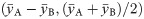
rCART association graphs for effect size.A,B: ‘Hospitalizations’ response versus ‘Emergency visits’ partition variables, with correlation r(rpbd, ρpb) = 0.93. C,D: ‘Emergency visits’ response versus ‘Hospitalizations’ partition variables, with correlation r(rpbd, ρpb) = 0.49. Bar plot histograms are shown for ‘Emergency visits’ (B inset) and ‘Hospitalizations’ (D inset). rpb: point-biserial correlation coefficient, {pA, pB}: sample size proportions, rpbd: sample size corrected correlation coefficient, ρpb: nonoverlap proportion, (δ, μ): center of mass parameters (y¯A-y¯B,(y¯A+y¯B)/2).